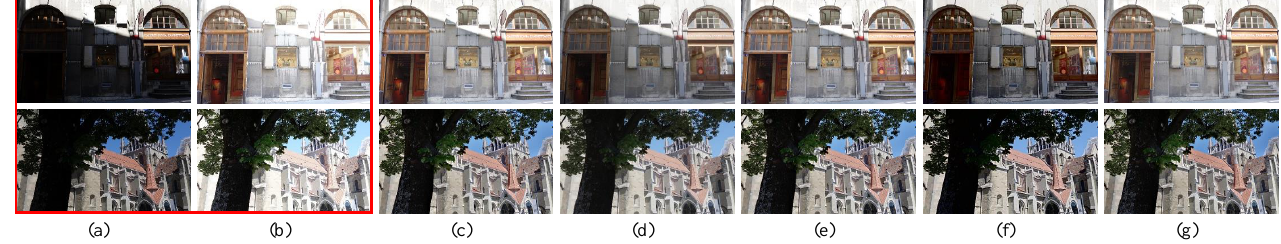
Figure 4. Comparison of the results obtained using different fusion methods with an underexposed and an overexposed input. ( a , b ) show the input images squared in red. The fusion results were obtained using ( c ) Kou’s method [8], ( d ) DeepFuse [10], ( e ) Yang’s method [9], ( f ) U2Fusion [13], and ( g ) the proposed